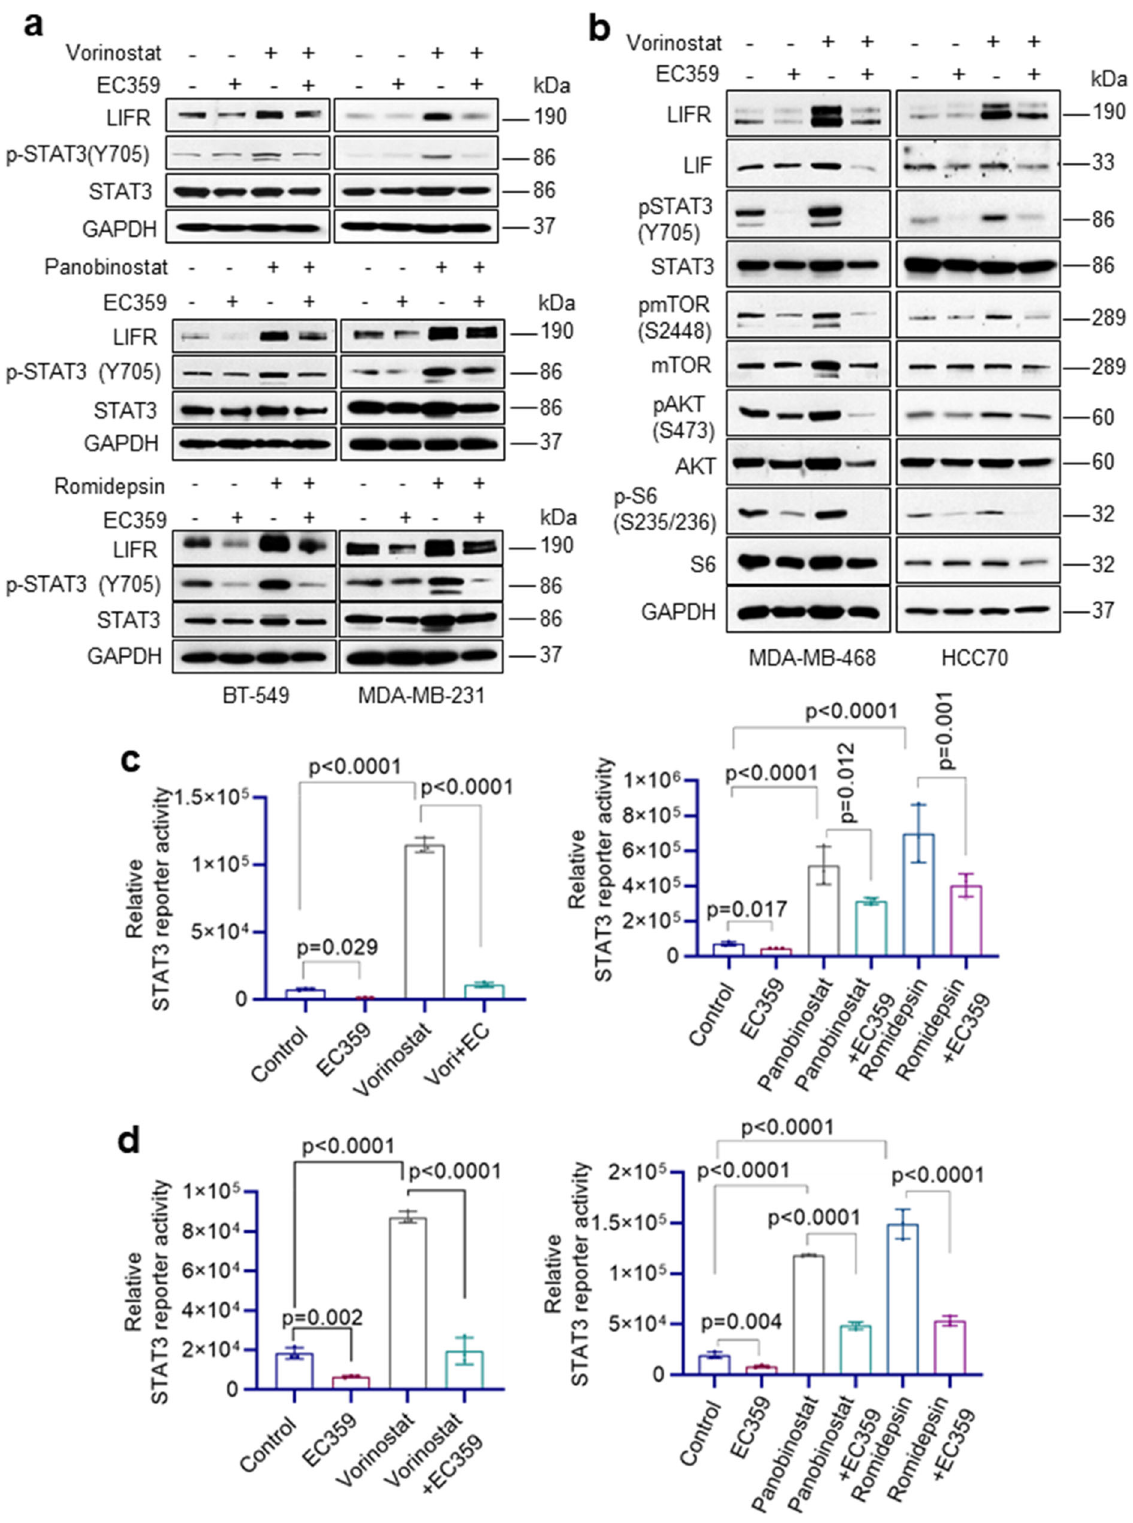
Fig. 4 EC359 inhibits HDACi induced LIFR signaling in TNBC cells. a BT-549 and MDA-MB-231 cells were treated with EC359 (100 nM) or HDACi (vorinostat (10 µ M) or panobinostat (500 nM) or romidepsin (100 nM)) alone or in combination for 10 h. Effect of EC359 on HDACi induced LIFR downstream signaling was measured using western blotting. b MDA-MB-468 and HCC70 cells were treated with EC359 (100 nM) or vorinostat (10 µ M) alone or in combination. Effect of EC359 on vorinostat-induced LIFR downstream signaling was measured using western blotting. Effect of EC359 on HDACi induced STAT3-Luc activity in BT-549 ( c ) and MDA-MB-231 ( d ) cells was determined using reporter assays. Data are representative of three independent experiments ( n = 3). Error bars represent SD. In c , d , p -values were calculated using two-way ANOVA.